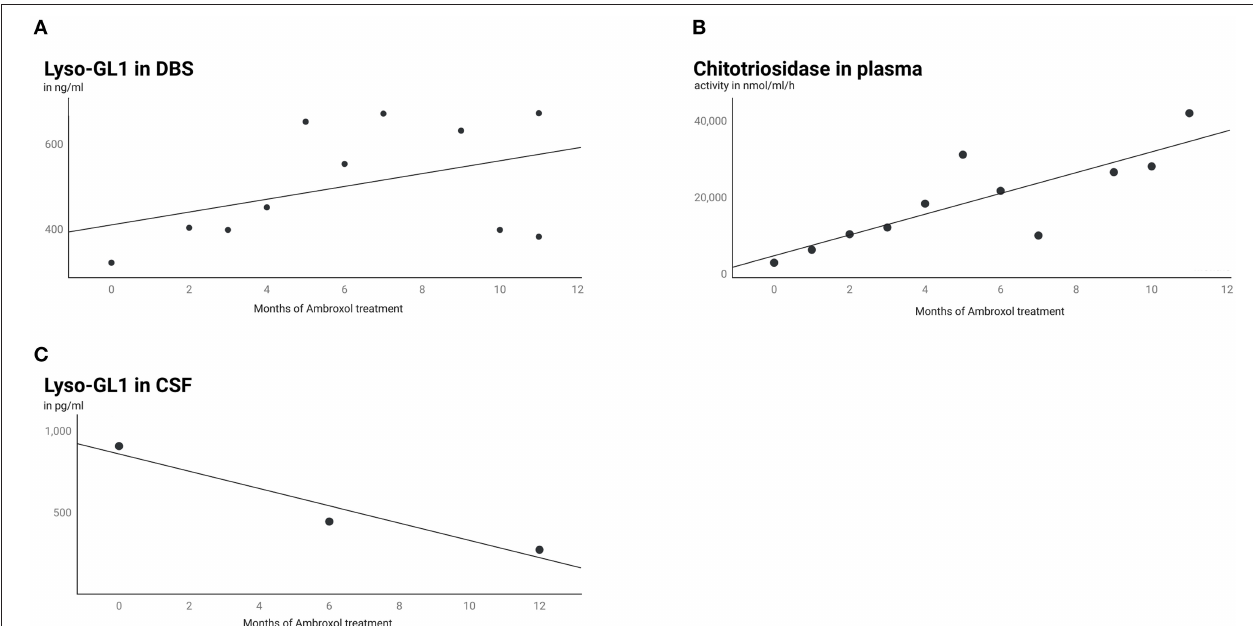
FIGURE 2 | Lyso-GL1 in DBS, Chitotriosidase in plasma and Lyso-GL1 in CSF. Continuous increase of Lyso-GL1 in DBS (A) and Chitotriosidase in plasma (B) over 12 months of ambroxol monotherapy and in contrast a continuous decrease of Lyso-GL1 in CSF (C) over 12 months of ambroxol monotherapy and another 12 months of combination of ambroxol and